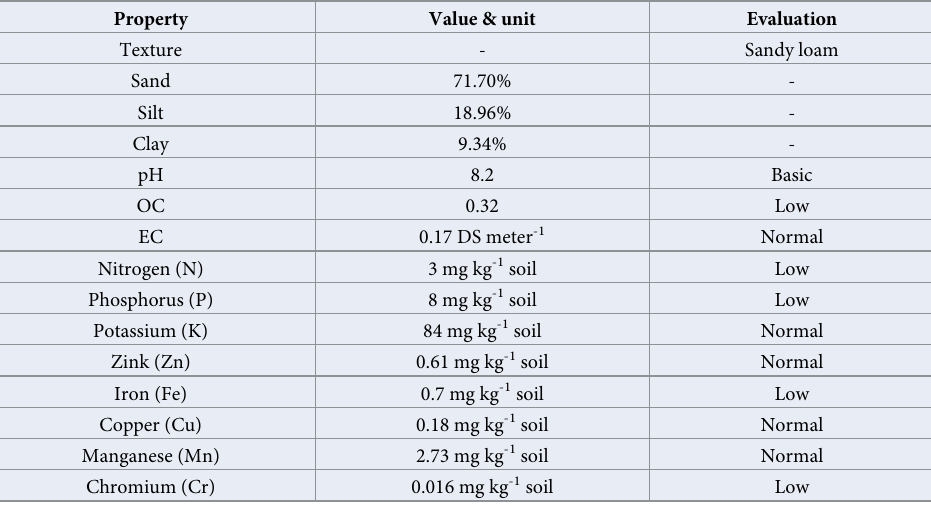
Table 1. Physicochemical properties of soil used during the present experiment.